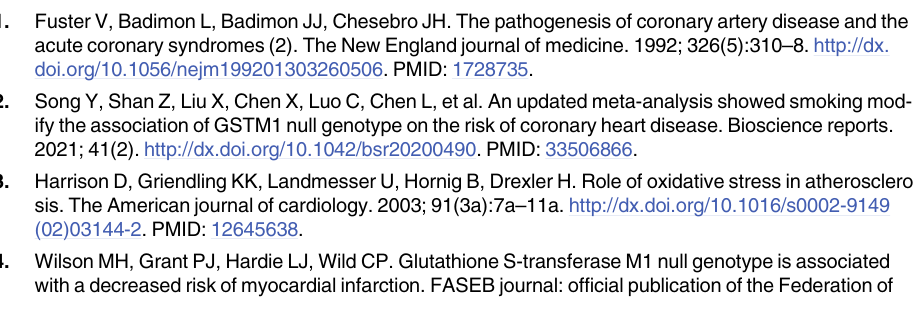
S1 Fig. PRISMA flowchart describing the included/excluded